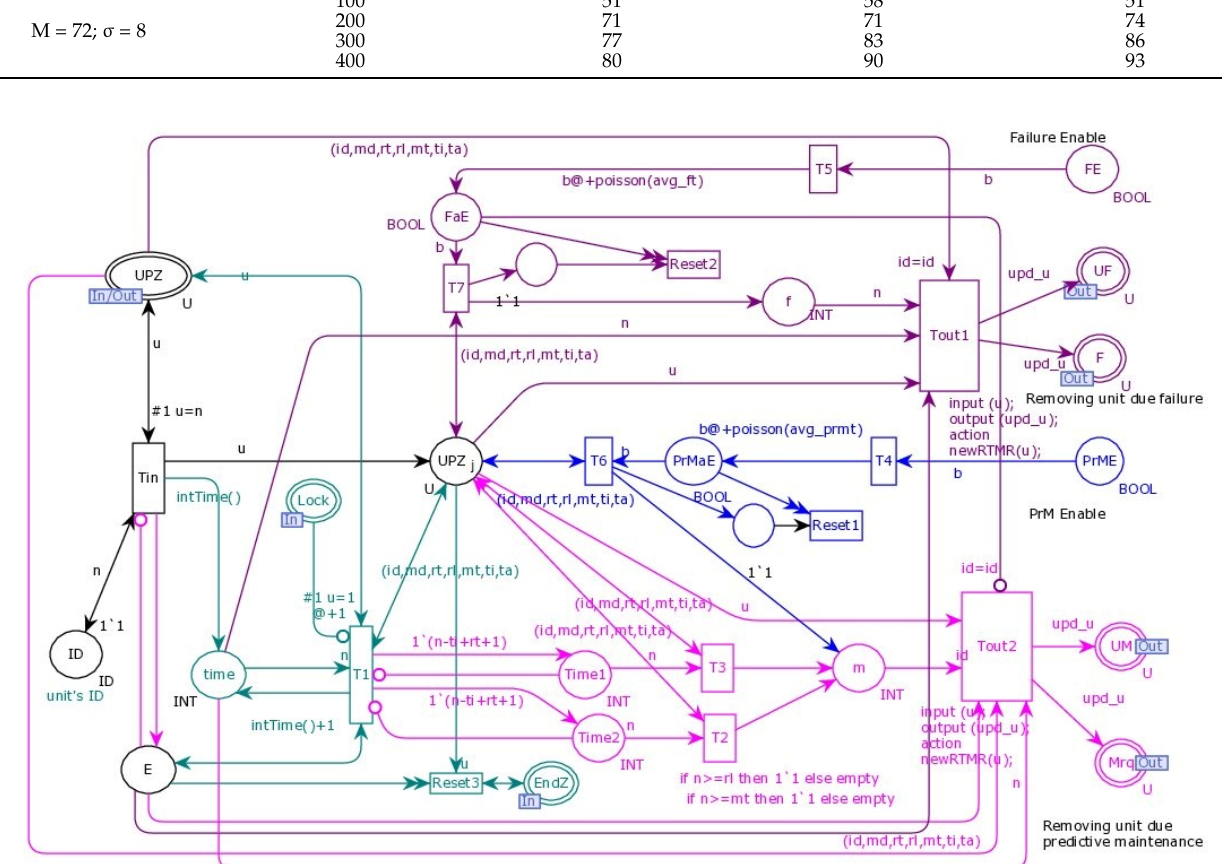
Figure A1. UNIT ID module.